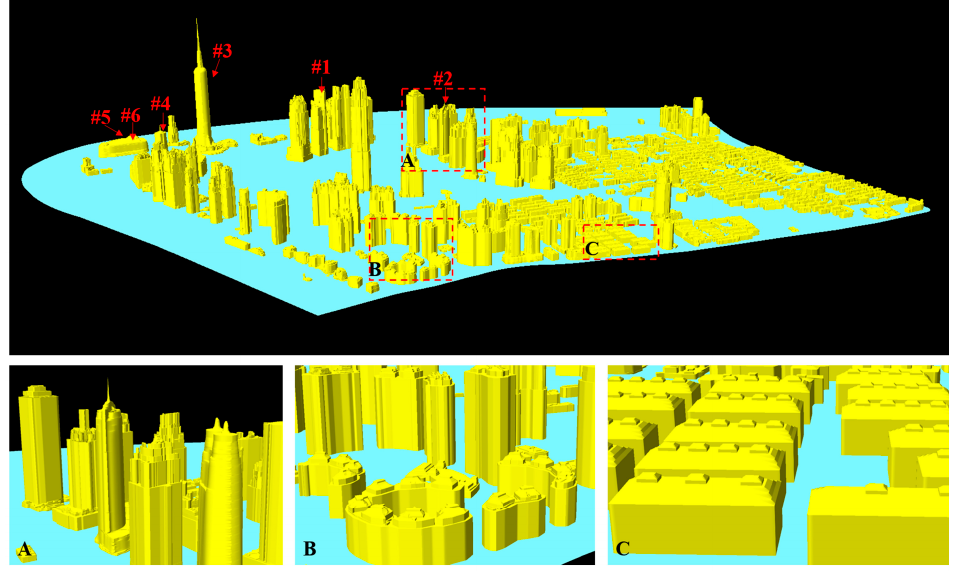
Figure 6. Reconstructed building models for the Lujiazui region: ( A ) the 3D building models for area A; ( B ) the 3D building models for area B; and ( C ) the 3D building models for area C.